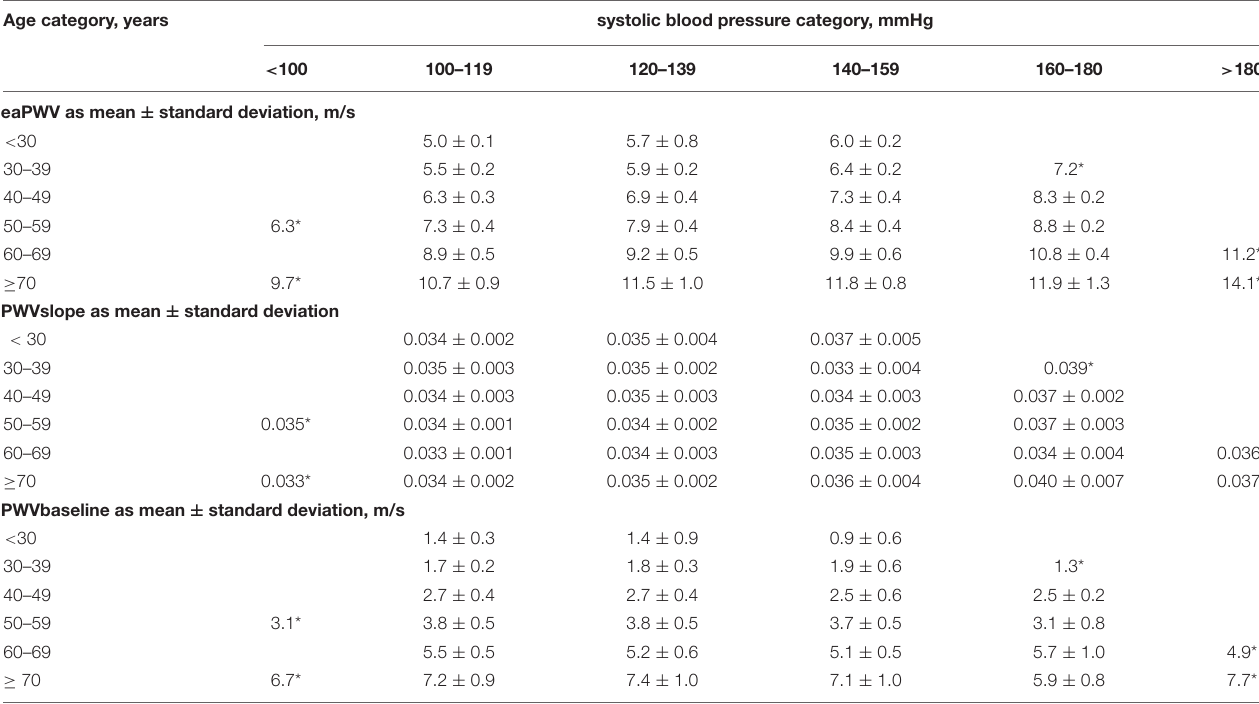
FIGURE 3 | Mean pulse wave velocity baseline (PWVbaseline) values (right graph) and PWVslope (left graph) according to the age and blood pressure categories. TABLE 2 | Distribution of estimated aortic pulse wave velocity (eaPWV), PWVslope, and PWVbaseline in the study population according to age and blood pressure